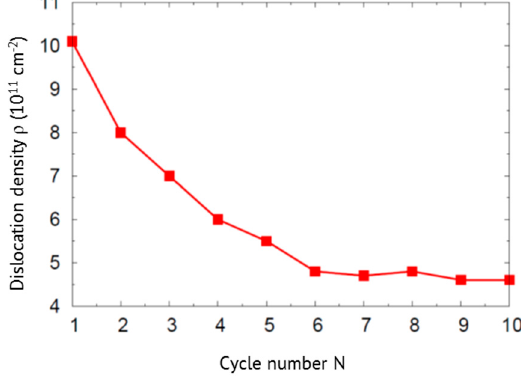
Figure 11. Dependence of the dislocation density in the plastic zone on cycle number.